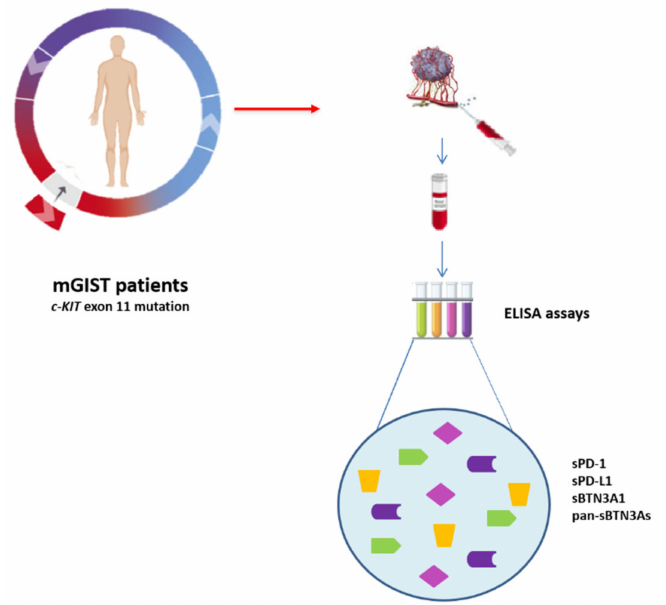
Figure 1. Analysis of circulating immune checkpoints in plasma from 30 c-KIT exon 11-mutated mGIST patients, using specific homemade ELISA tests.